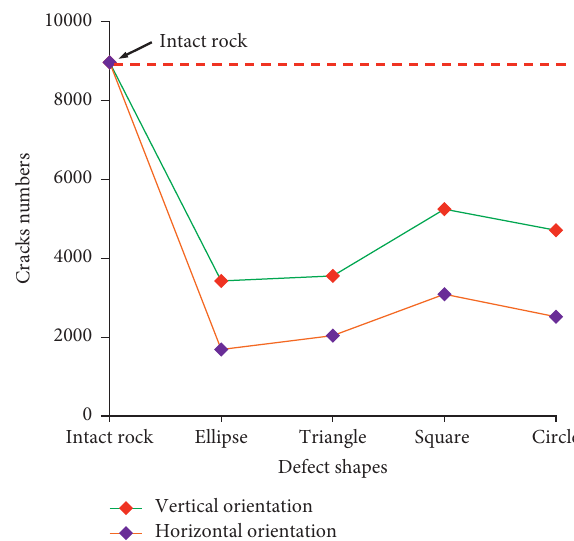
Figure 9: Total number of cracks after model